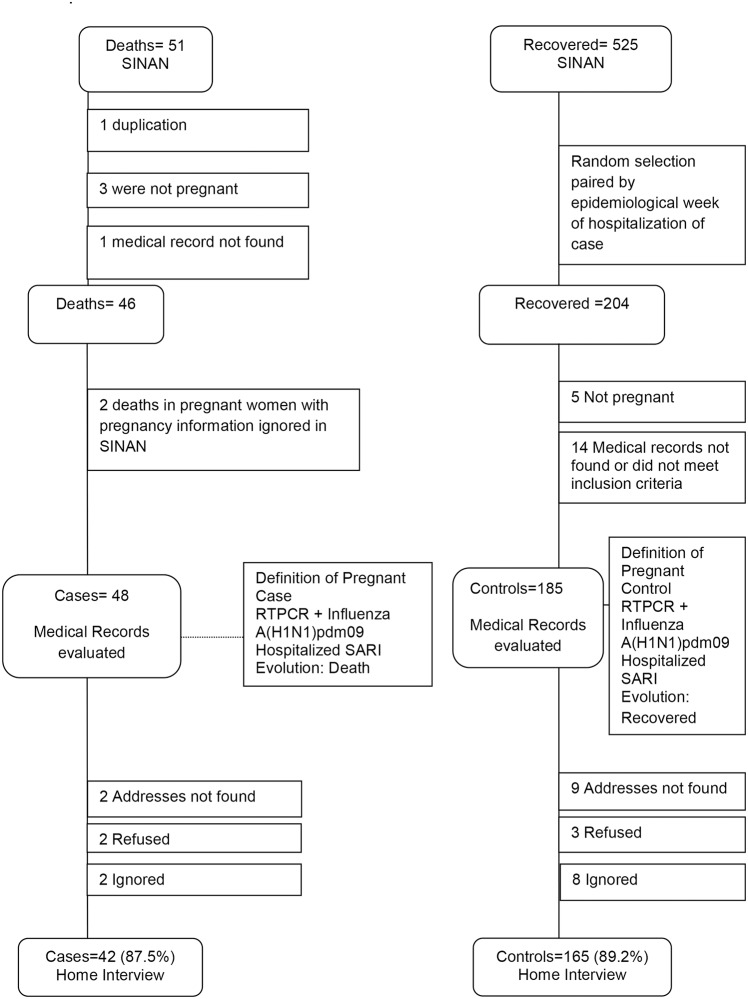
Flow chart for the selection of cases and controls among pregnant women reported in the National Disease Notification System—SINAN—São Paulo State, 2009.